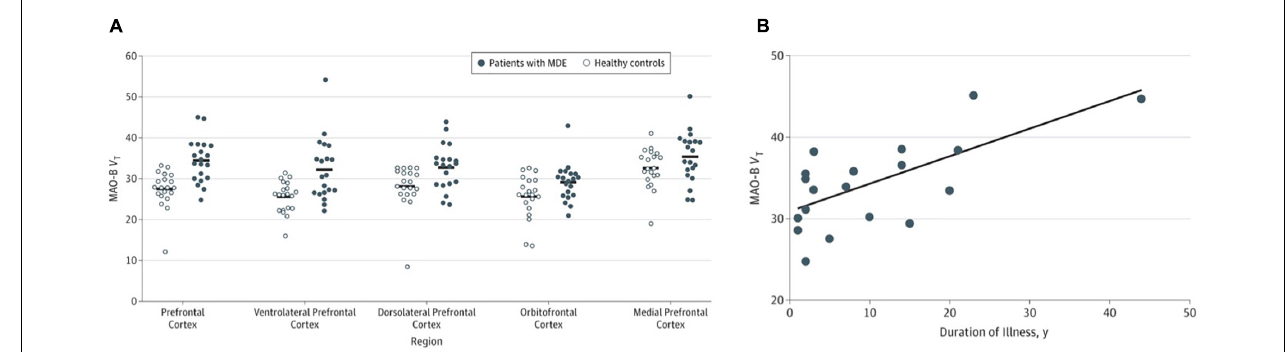
FIGURE 4 | (A) Significantly elevated monoamine oxidase B total distribution volume (MAO-B V T ) in the prefrontal cortex in patients during major depressive episodes ( n = 20) compared with healthy controls ( n = 20). (B) Relationship between prefrontal cortex MAO-B V T and duration of illness in major depression ( n = 20). Linear fit analysis, r = 0.68. Adapted with permission from Moriguchi et al. (2019). Copyright © (2019) American Medical Association. All rights reserved.